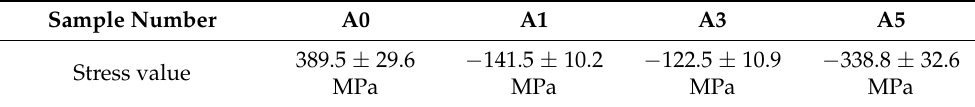
Table 2. Samples residual stress.